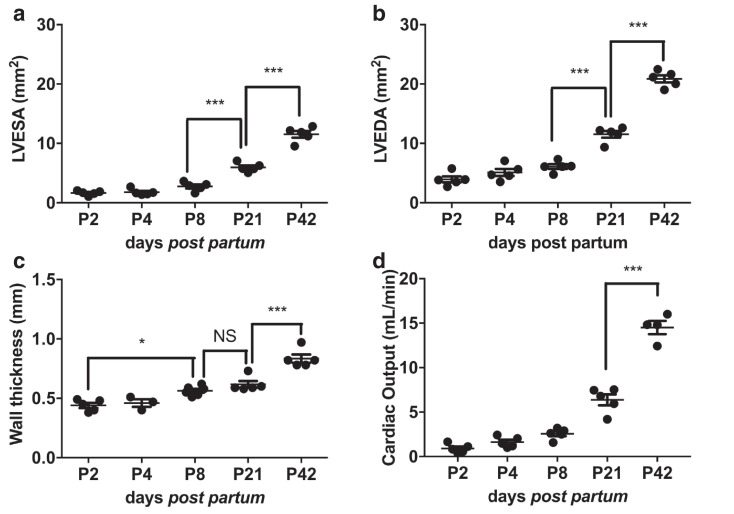
EKV ultrasound imaging allows investigation of cardiac structural changes in vivo from early neonatal to adult stages. Electrocardiogram-gated kilohertz visualisation (EKV) B-mode allowed calculation of (a) left ventricle end-systolic area (LVESA), (b) left ventricle end-diastolic area (LVEDA), (c) left ventricle wall thickness and (d) cardiac output; n = 3–5/group. Results are presented as mean ± standard error of the mean; p value determined with one-way analysis of variance with Bonferroni post hoc test. p > 0.05 (nonsignificant), *p < 0.05, ***p < 0.001.